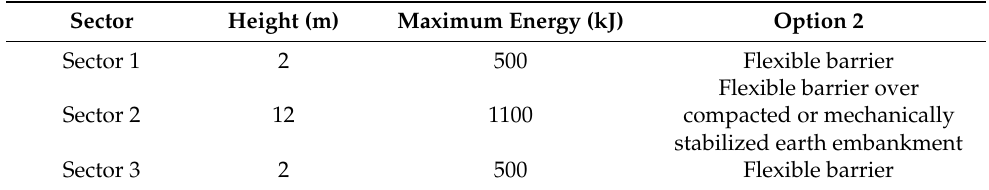
Table 9. Height and energy requirements for Option 2 rockfall protection.